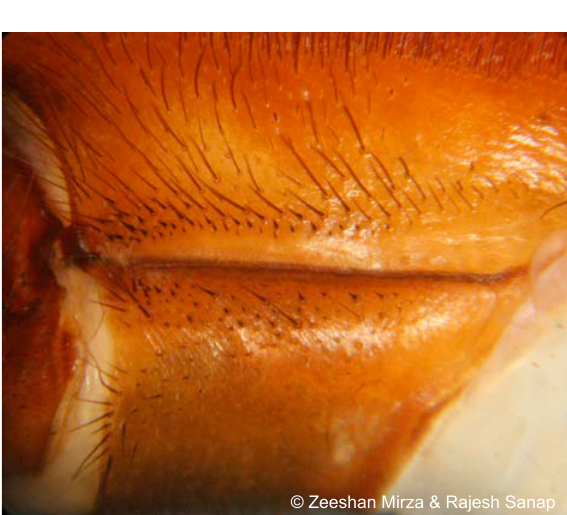
Image 4. Haploclastus validus female maxillae prolateral view. Not in